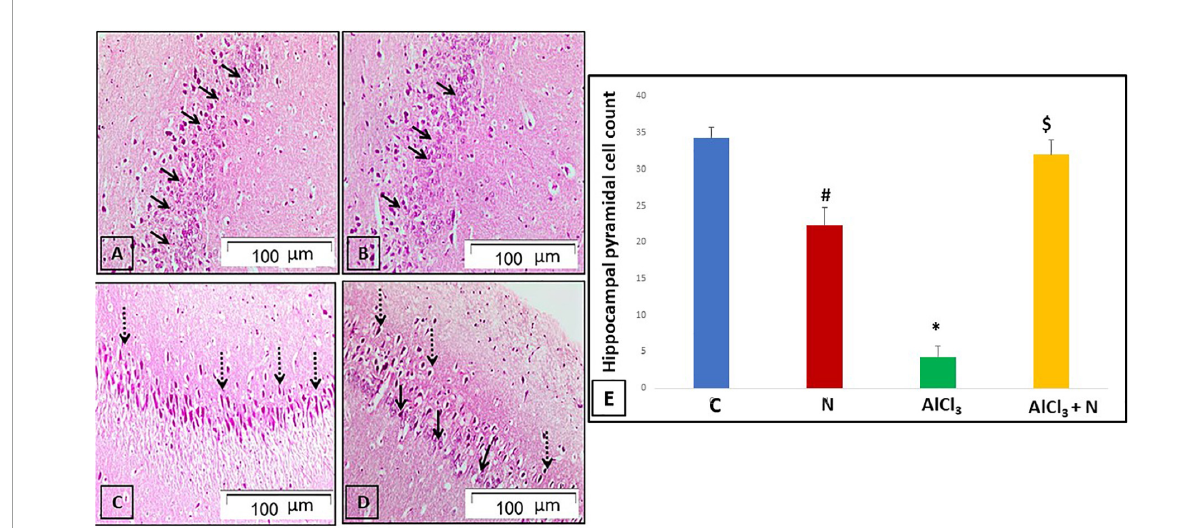
FIGURE5 H & E-stained hippocampal sections revealing the cornu amonnis region 1 (CA1): (A , B) C and N groups, respectively showed its pyramidal cell layer formed of small pyramidal neurons with large vesicular nuclei and prominent nucleoli (arrows). (C) AlCl 3 group showed that most of the pyramidal neurons appeared to be deeply stained with pyknotic nuclei (dotted arrows). (D) The group treated with both AlCl 3 and N showed that most of pyramidal neurons appeared normal with large vesicular nuclei and prominent nucleoli (arrows). However, some pyramidal neurons appeared deeply stained with pyknotic nuclei (dotted arrows) (H & E, × 200). (E) Pyramidal cell count of all studied groups. n = 6 in each group. Data were prescribed as mean ± SD . The intergroup variation was conducted by Games-Howell post-hoc test. ∗ p < 0.001 compared with C group. # p = 0.004 compared with AlCl 3 . $ p < 0.001 compared with AlCl 3 .